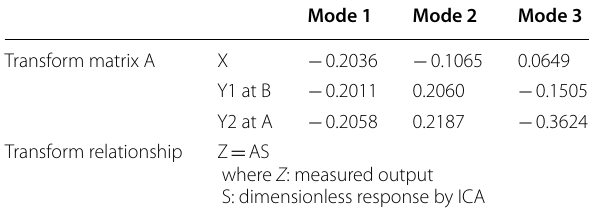
by converting the non-dimensional decomposed modes into acceleration quantities according to the relation given in Table 7. The correlation between the restored